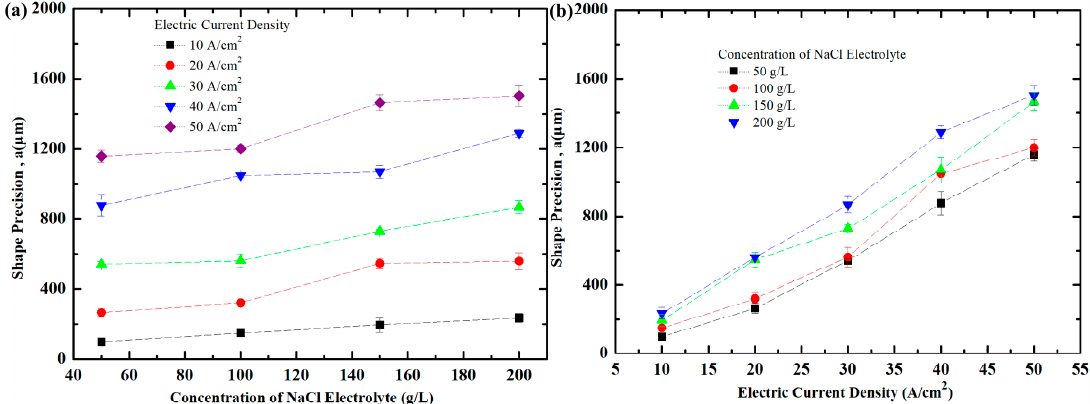
Figure 8. ( a ) Shape precision at different concentration of NaCl electrolyte; ( b ) Shape precision at different current density in NaCl electrolyte.